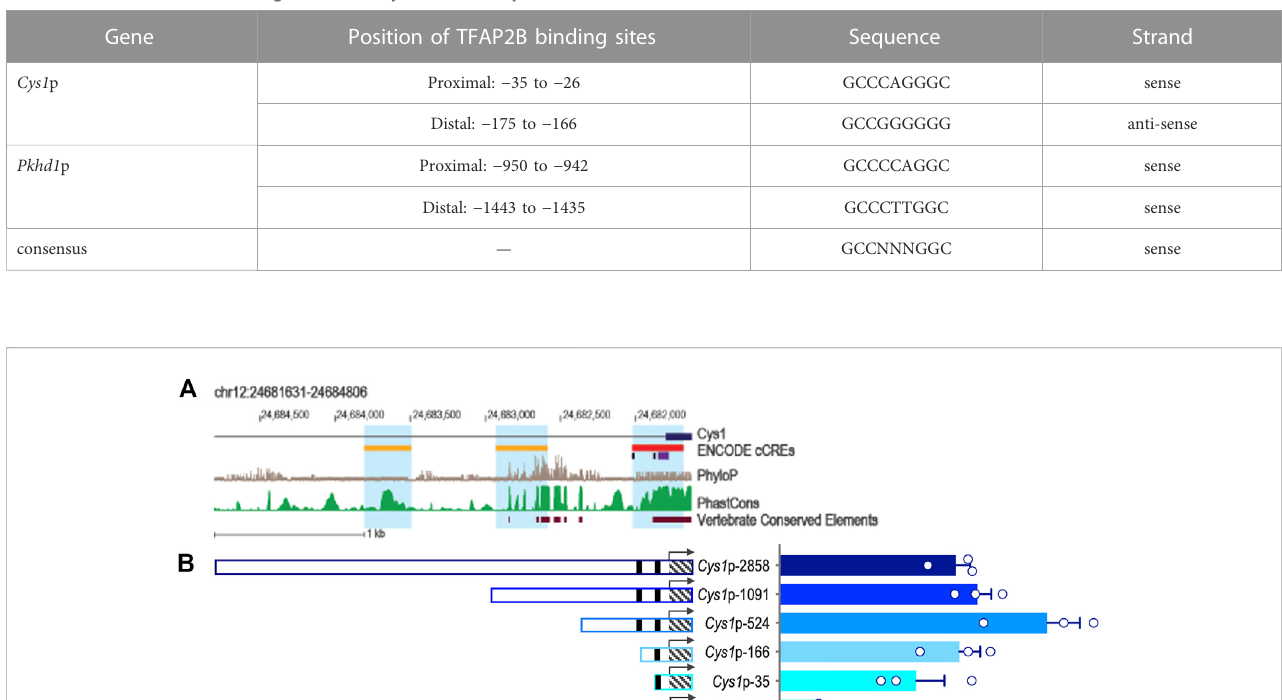
(Table 2; Figure 2B). Reporter activity directed by Cys1 p-35 with one TFAP2B binding site was notably increased relative to the Cys1 p-26 construct lacking a TFAP2B binding site (Figure 2B),